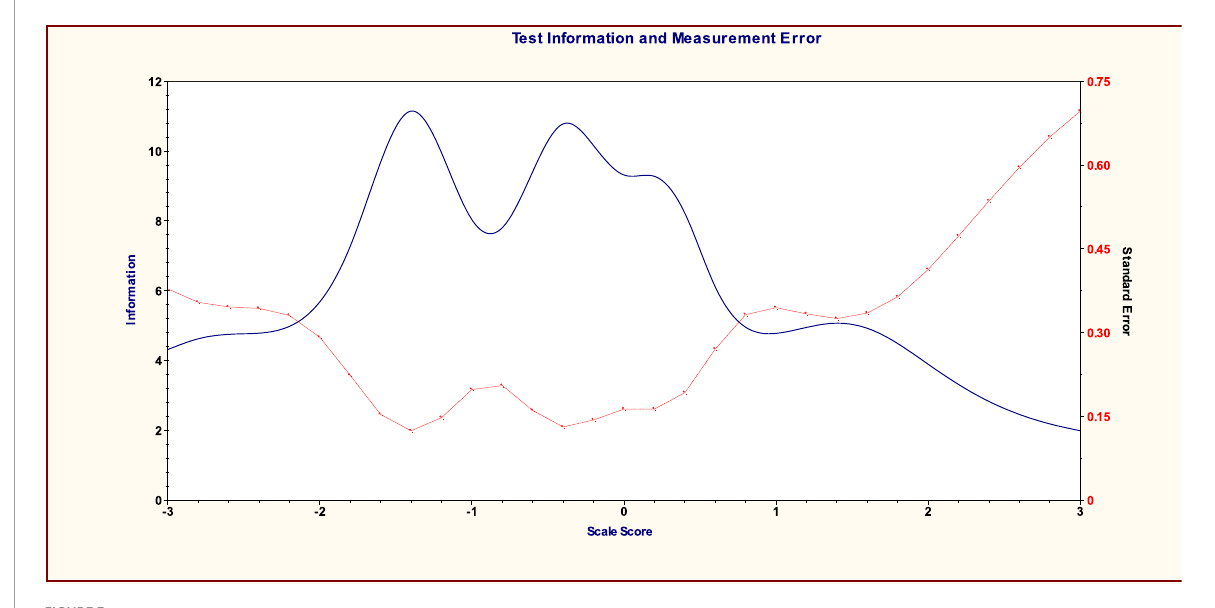
FIGURE3 Test Information Function and Measurement Error Curves – Grade Response Model. The test information curve is represented by the solid line. The standard error of measurement curve is represented by the dotted